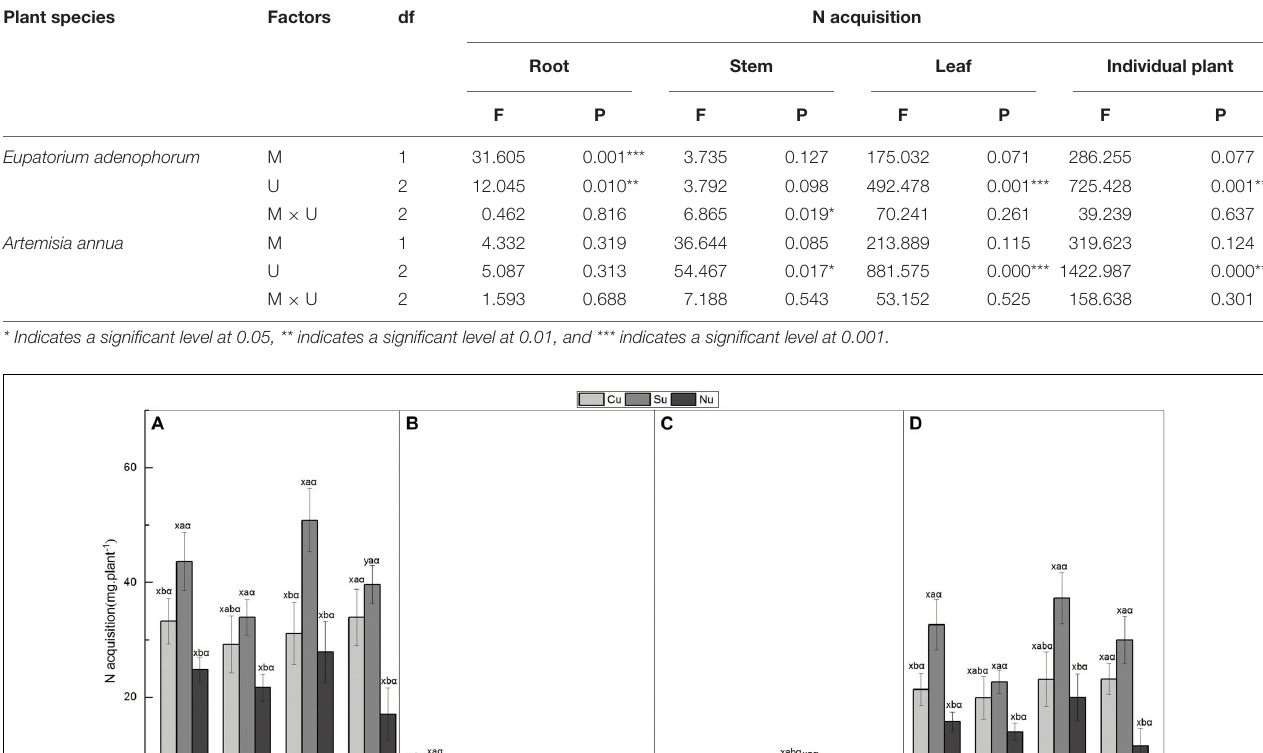
TABLE 3 | Two-Way ANOVAs for the effects of mycorrhizal fungus (M + vs M − ) and nutrient utilization treatments (Cu vs Su vs Nu) on N acquisition of the invasive plant Eupatorium adenophorum and the native plant Artemisia annua . Plant species Factors df N acquisition Root Stem Leaf Individual plant